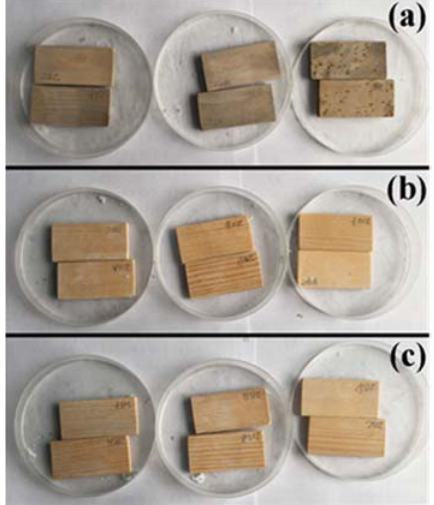
Figure 1. Mold infection of ( a ) original wood, ( b ) wood sample impregnated with Ag / TiO 2 nanoparticles via ultrasound (UW), and ( c ) wood sample impregnated with Ag / TiO 2 nanoparticles via vacuum assistance (VW).